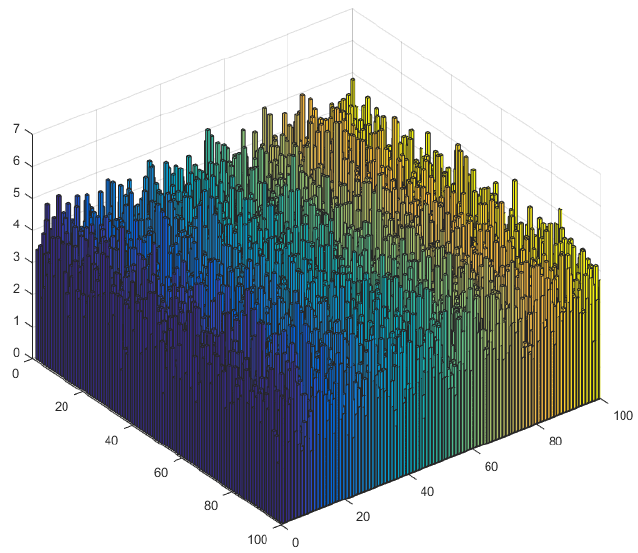
Figure 4. Example of catalyst inlet boundary condition data. Table 2. Design of the temperature random field (different averaged values of